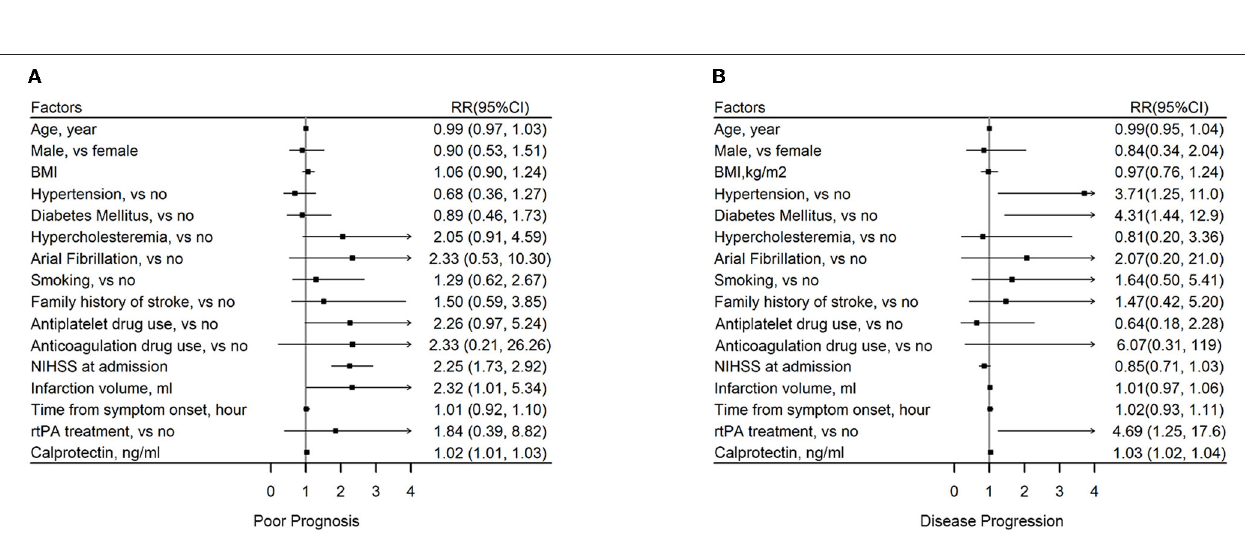
Frontiers in Neurology |